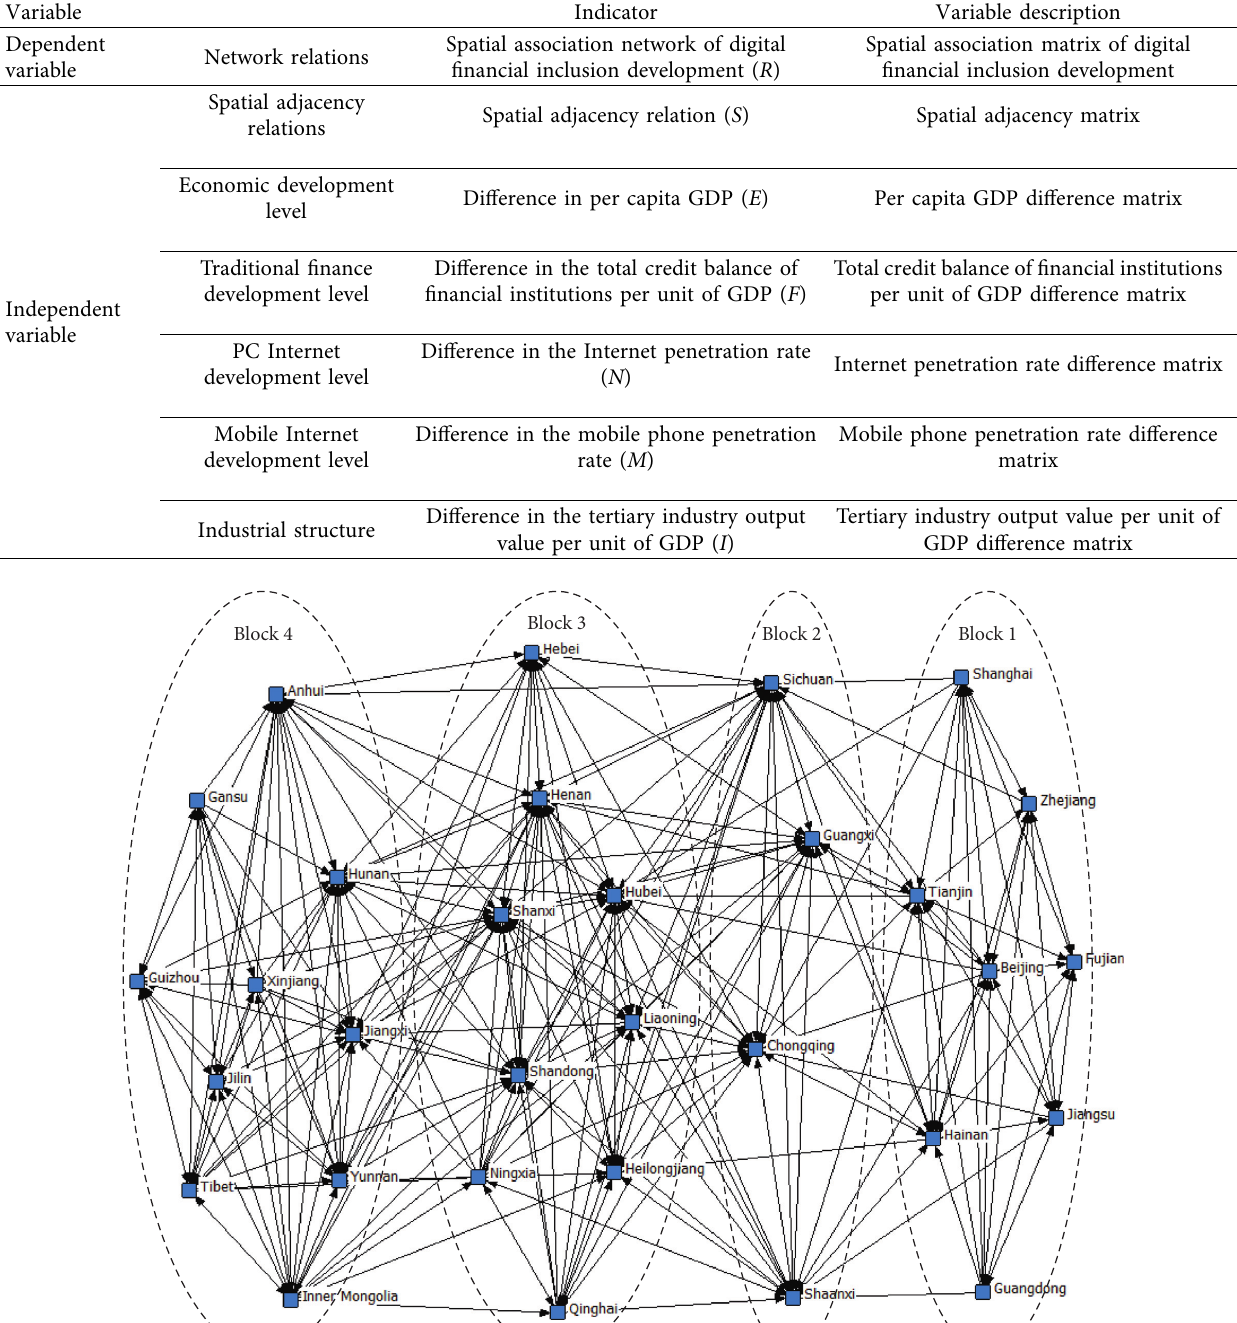
Table 1: Variables and indicators.